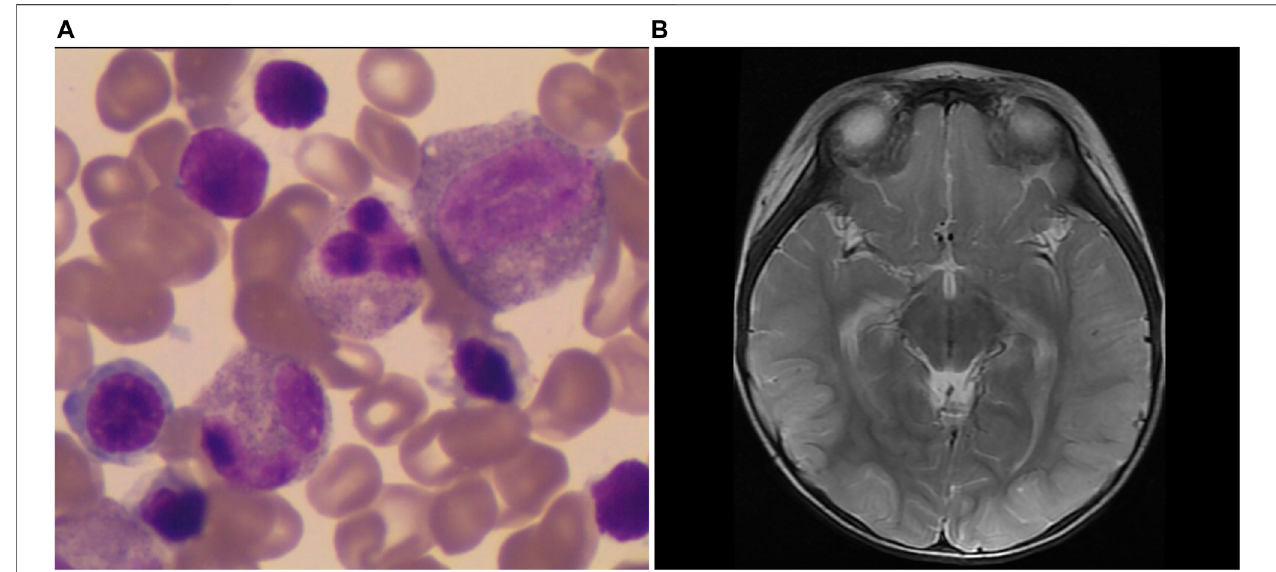
FIGURE 1| The patient ’ smain clinical characters. (A) Bone marrowaspirate showed markedly active myeloproliferation with impaired megakaryocyte maturation. (B) The brain DWI image. It showed linear hyperintensity in the left occipital lobe on diffusion-weighted imaging (DWI).